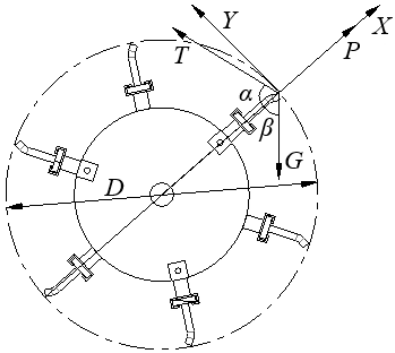
Figure 4. Radial force analysis of the peanut root disk.